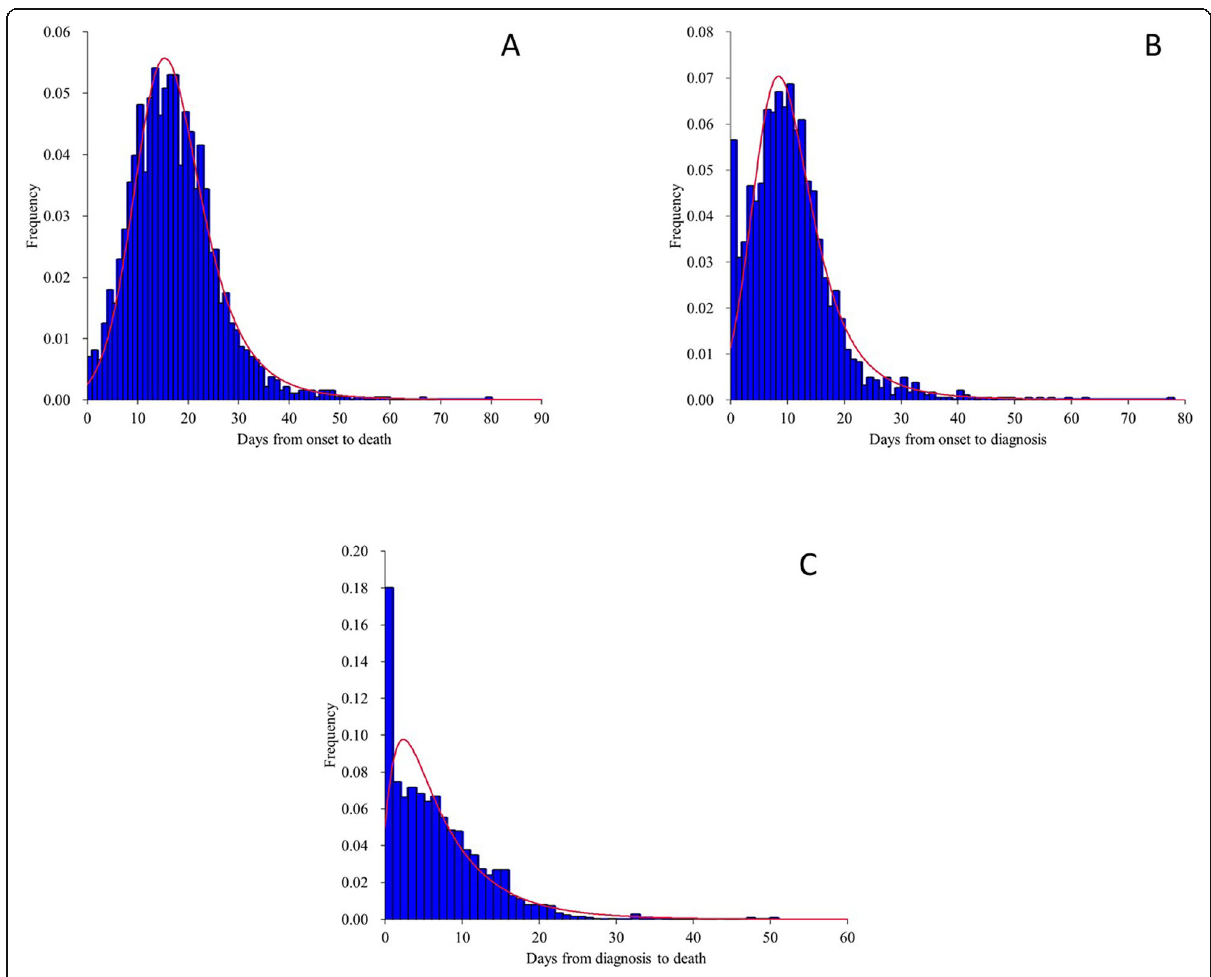
Fig. 3 Time distribution of interval from onset to death ( a ), interval from onset to diagnosis ( b ) and interval from diagnosis to death ( c